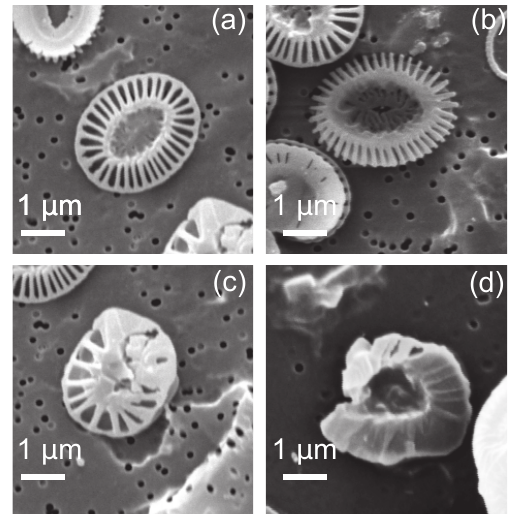
Figure 2. SEM images of Emiliania huxleyi coccoliths. (a) Nor- mal coccolith; (b) incomplete coccolith; (c) malformed coccolith; (d) malformed and incomplete